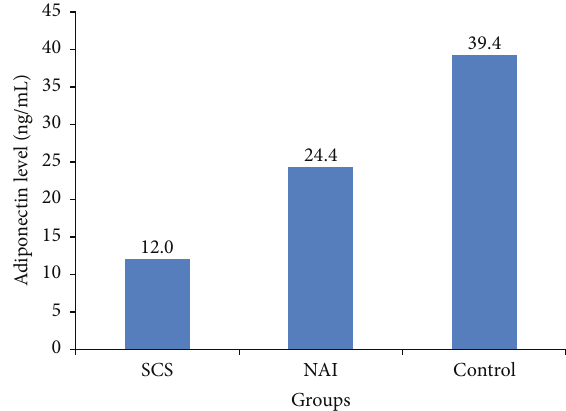
Figure 1: Adiponectin levels in the study groups. SCS, subclinical Cushing’s syndrome; NAI, nonfunctional adrenal incidentaloma.